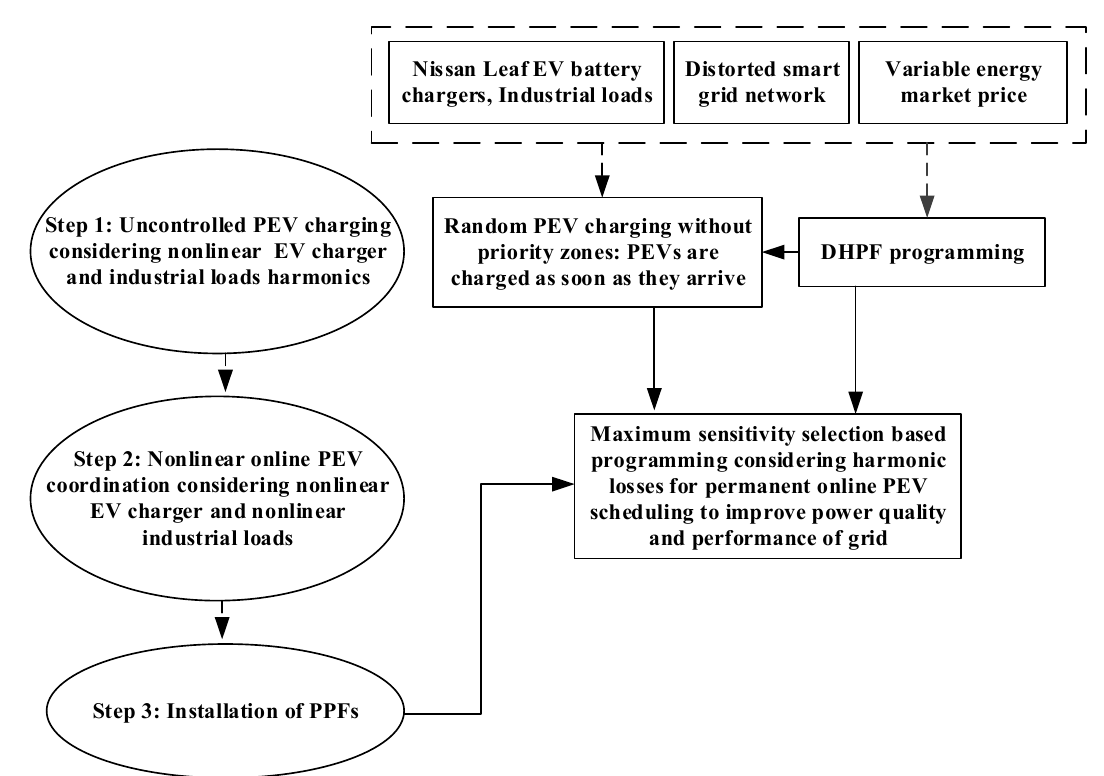
Figure 1. Schematic overview of the proposed nonlinear online plug-in electric vehicle (PEV) coordination approach considering harmonics.